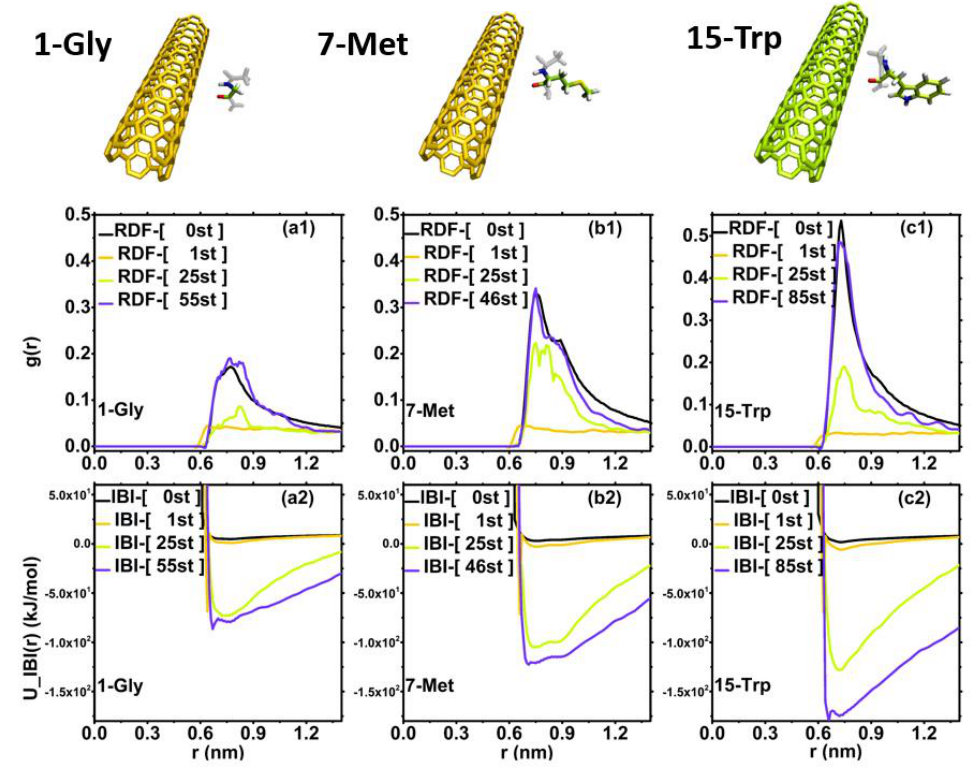
Figure 4. Representative amino acid studies: (1) short-chain non-polar amino acid 1-Gly, ( a1 ) RDF iteration, ( a2 ) IBI potential energy iteration; (2) long-chain non-polar amino acid 7-Met, ( b1 ) RDF iteration, ( b2 ) IBI potential energy iteration; (3) Aromatic amino acid 15-Trp, ( c1 ) RDF iteration, ( c2 ) IBI potential energy iteration.